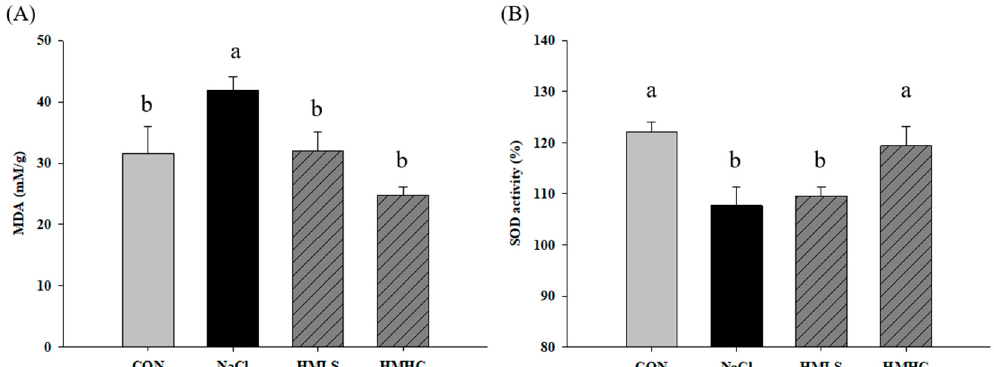
Figure 4. Effects of mineral-balanced DSW on antioxidant effect in kidney tissue: ( A ) malondialdehyde, and ( B ) SOD activity (%). CON, normal diet + distilled water; NaCl, 8% NaCl diet + distilled water; HMLS, 8% NaCl diet + high magnesium low sodium water; HMHC, 8% NaCl diet + high magnesium high calcium water. Different letters above the bars indicate significant differences (Duncan’s multiple range test; p < 0.05).